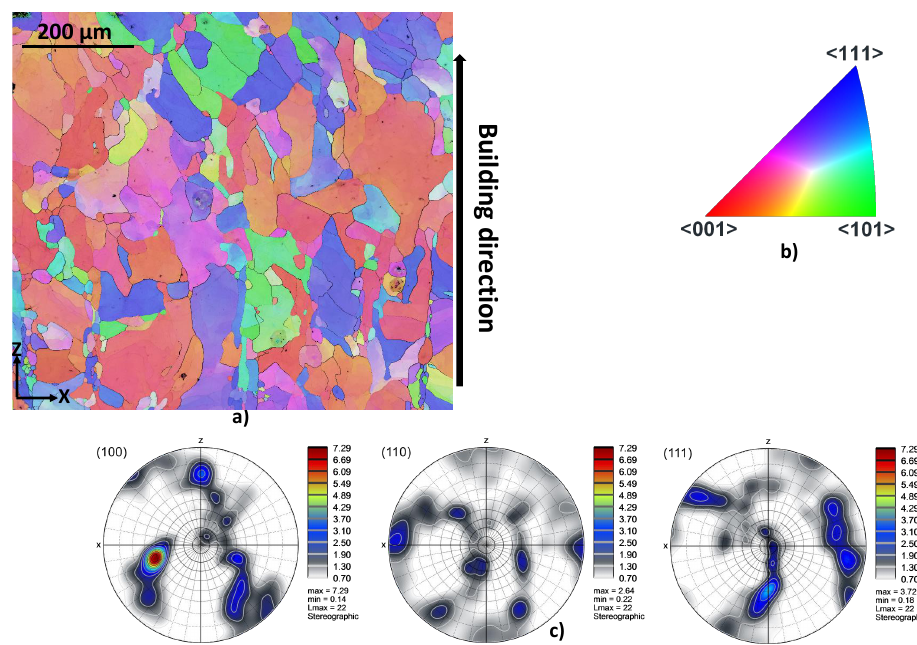
Figure 5. EBSD map taken in the center of the as-LB-PBFed Ti42Nb specimen produced with a building directions of 45 ◦ (projection axes (cid:104) 101 (cid:105) ): ( a ) inverse pole figures (IPF (Z)), ( b ) IPF coloring legend, ( c ) pole figures